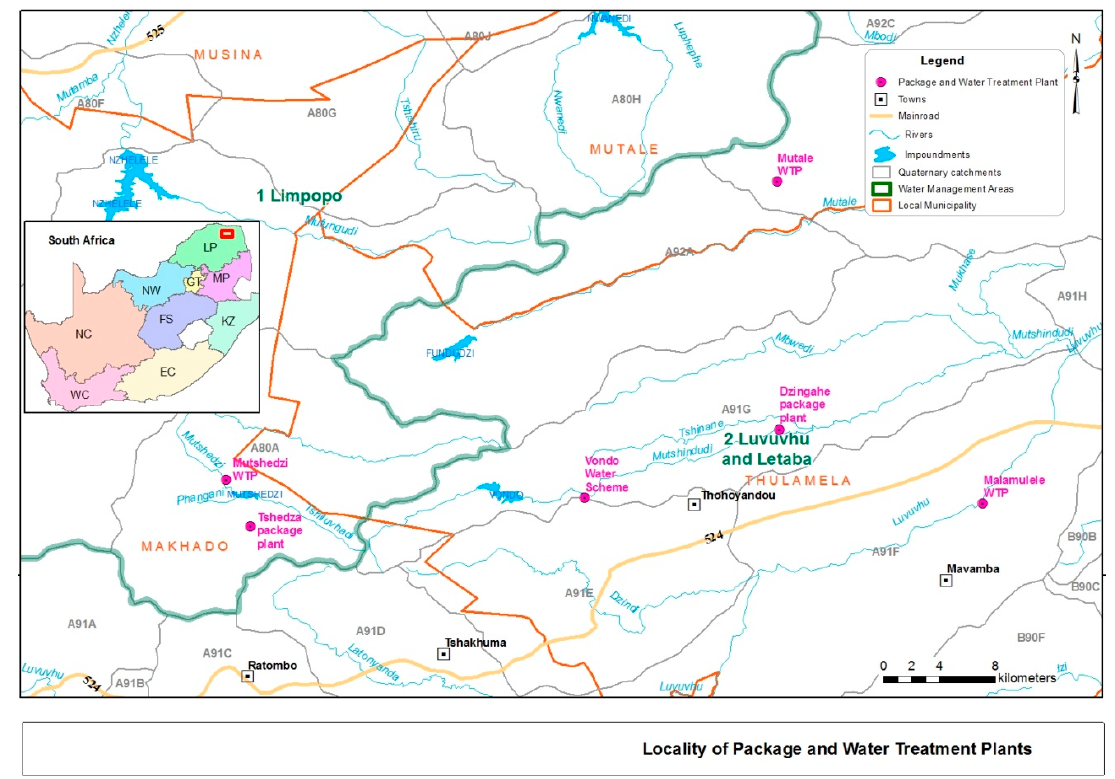
Figure 1. South African map with the location of the water treatment plants.